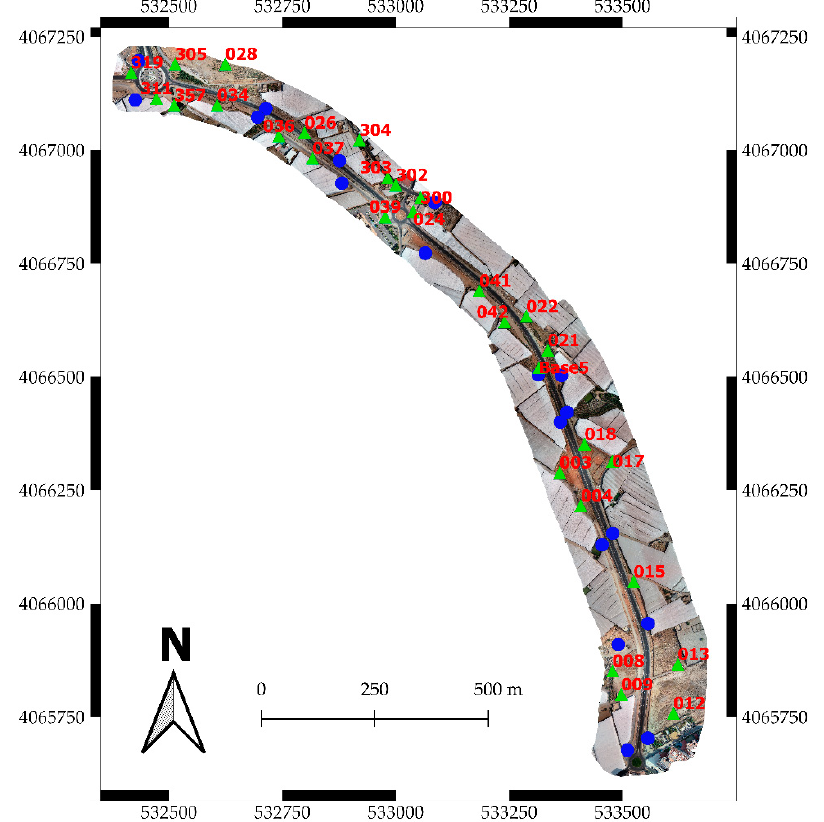
Figure 4. Location of the 47 targets used as GCPs (blue dots) and check points (CPs) (green triangles). The coordinates refer to UTM Zone 30N (ETRS89). The red numbers indicate the CP labels.